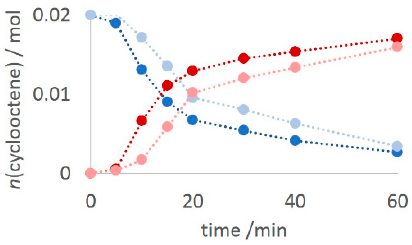
Figure 3. Cyclooctene conversion (falling curves) and corresponding epoxide formation (rising curve) for the first 60 min of the reaction. Dark red and dark blue curves present the reaction with the catalyst [MoO 2 (L 3OMe )(MeOH)], while pale red and pale blue curves present the reaction with the catalyst [MoO 2 (L 3OMe )] n .